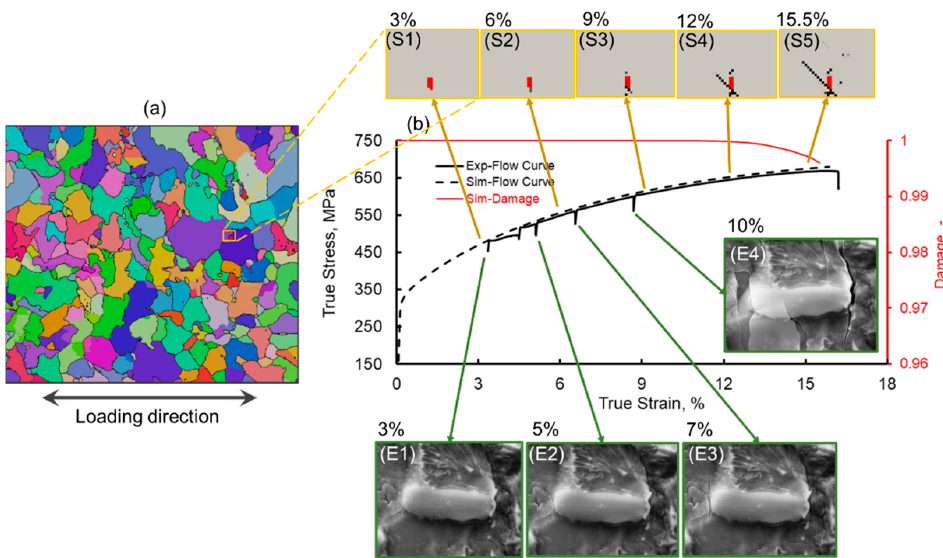
Figure 8. ( a ) RVE chosen to run full phase simulations in IPF colors; yellow box represents one of the crack initiation zones. ( b ) Outcome of the simulation flow curve in comparison with the in situ experimental test results, showing a good match; the dips in the experimental results are the points where the test was stopped to take local pictures of the inclusions for later DIC. E1–E4 show the damage evolution around an MnS inclusion, S1–S5 inset figures show the damage evolution around a comparable MnS inclusion during numerical simulation.